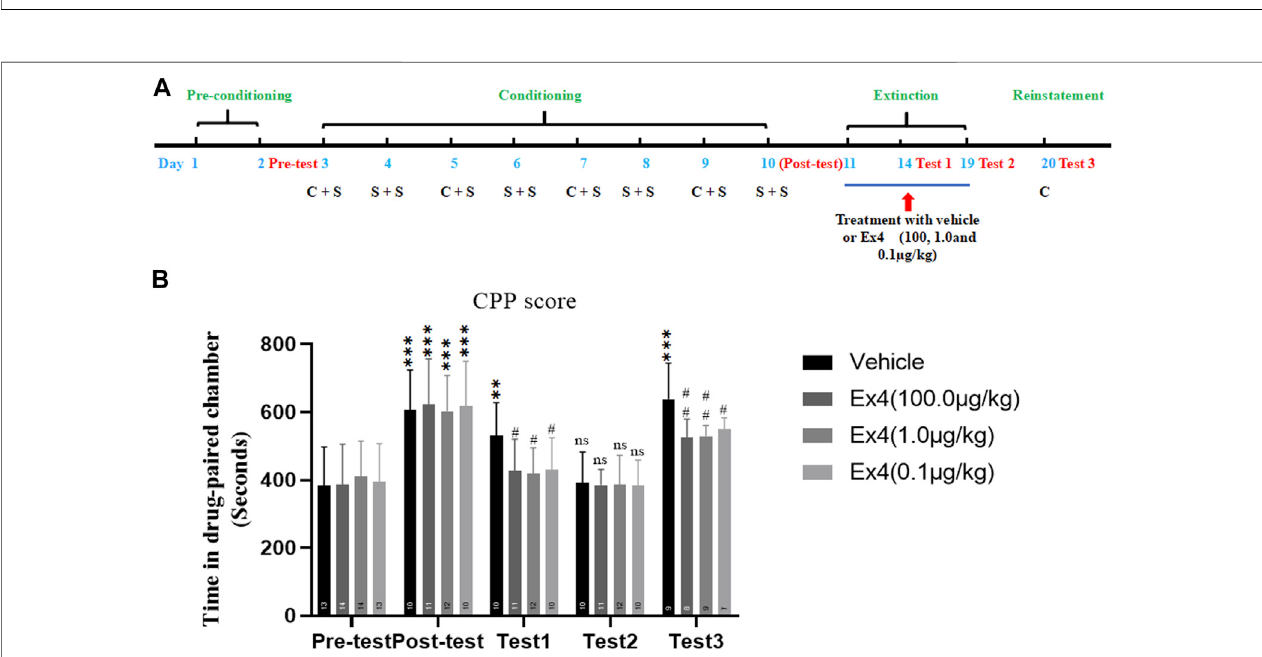
FIGURE3| Ex4 ’ schronictreatmentfacilitatesextinctionandinhibitsreinstatementofcocaine-inducedCPP. (A) Theexperimental scheduleforsaline(S)aswellas cocaine (C) and Ex4 treatments. (B) CPP scoresfollowing systemic treatment with vehicle and Ex4 (100, 1.0, and 0.1 μ g/kg) during the extinction show thatpost- extinction Ex4 treatment facilitates extinction of CPP and inhibits cocaine-primed reinstatement comparedto the vehicle group. ** and *** represent p < 0.01 vs pretest and p < 0.01 vs pretest, ns represents no signi fi cantdifference, Student ’ s t test. # and ## represent p < 0.05 vs vehicle and p < 0.01 vs vehicle, one-way ANOVA followed by a Dunnett ’ s post hoc test. All data are presented as the mean ± SEM.